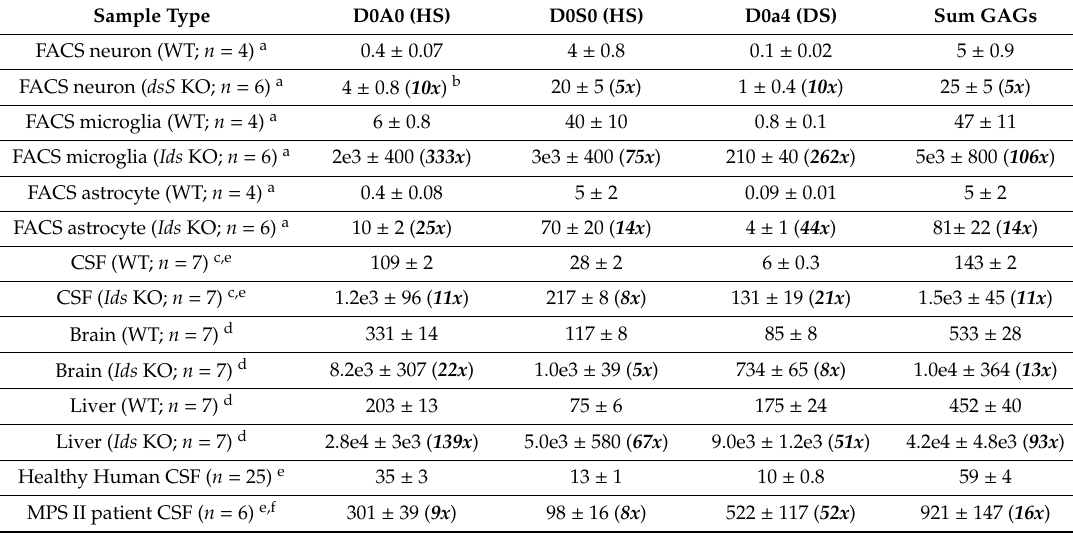
Table 3. HS and DS concentration in FACS-isolated neurons and microglia, CSF, brain, and liver in mice, and CSF of healthy human subjects and MPS II patients (Mean ±